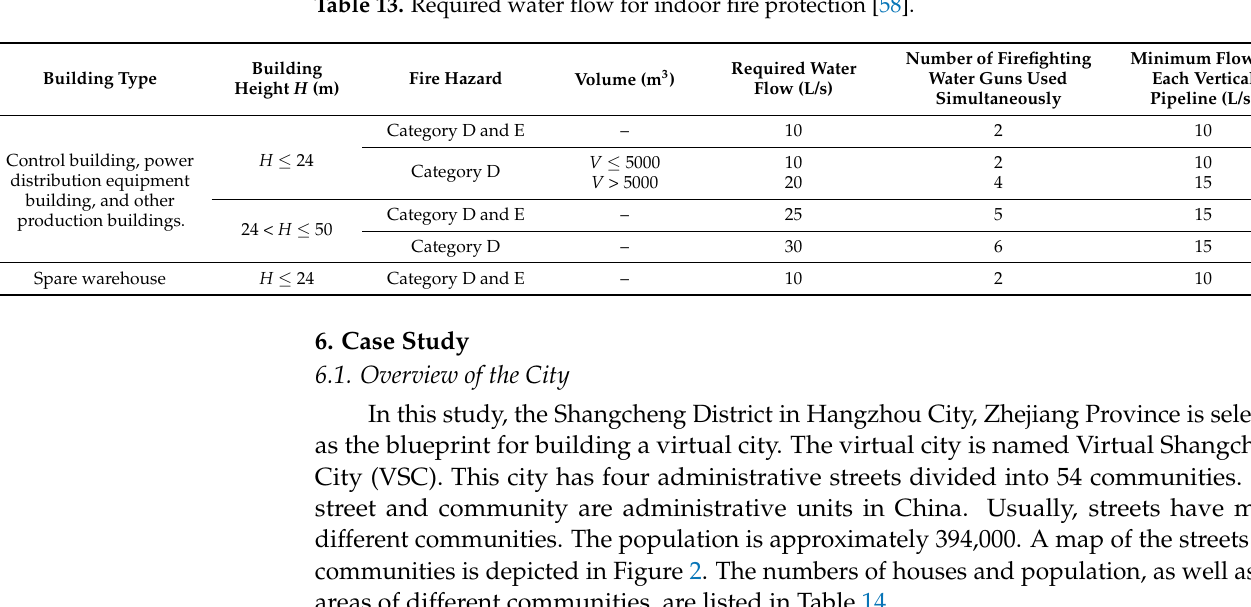
Table 13. Required water flow for indoor fire protection [58].